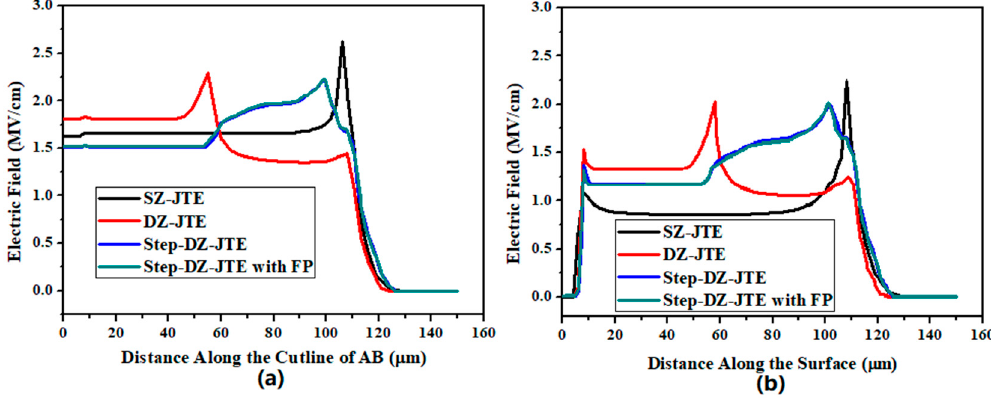
Figure 7. Simulated electric field distribution at OFF-state breakdown ( a ) along the cutline of AB and ( b ) on the surface for SZ-JTE, DZ-JTE, Step-DZ-JTE with FP (dose1/dose2 = 3, and JTE1 dose = 2 × 10 13 cm − 2 ).